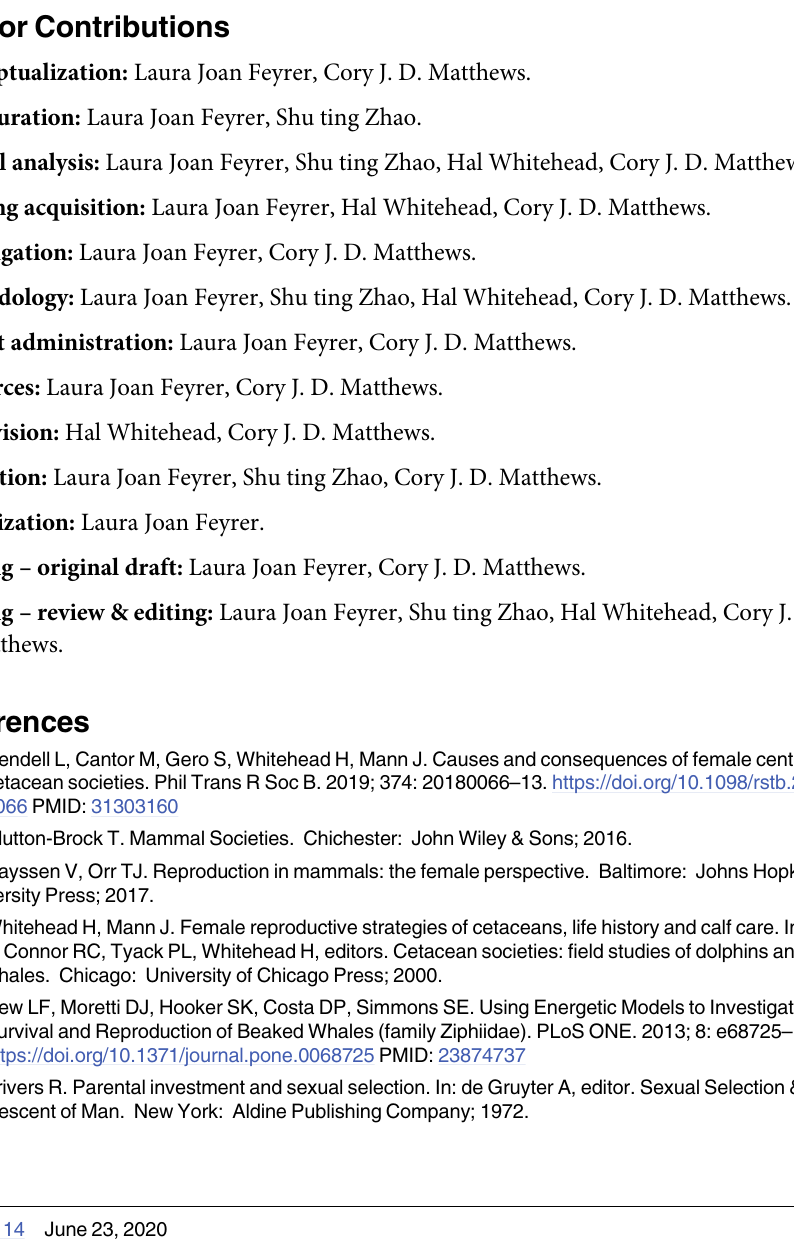
S1 Table. Summary of cetacean studies reporting nursing duration or weaning age by spe- cies, method, average age at weaning, and sample type. S2 Table. Rationale for inclusion of variables and data